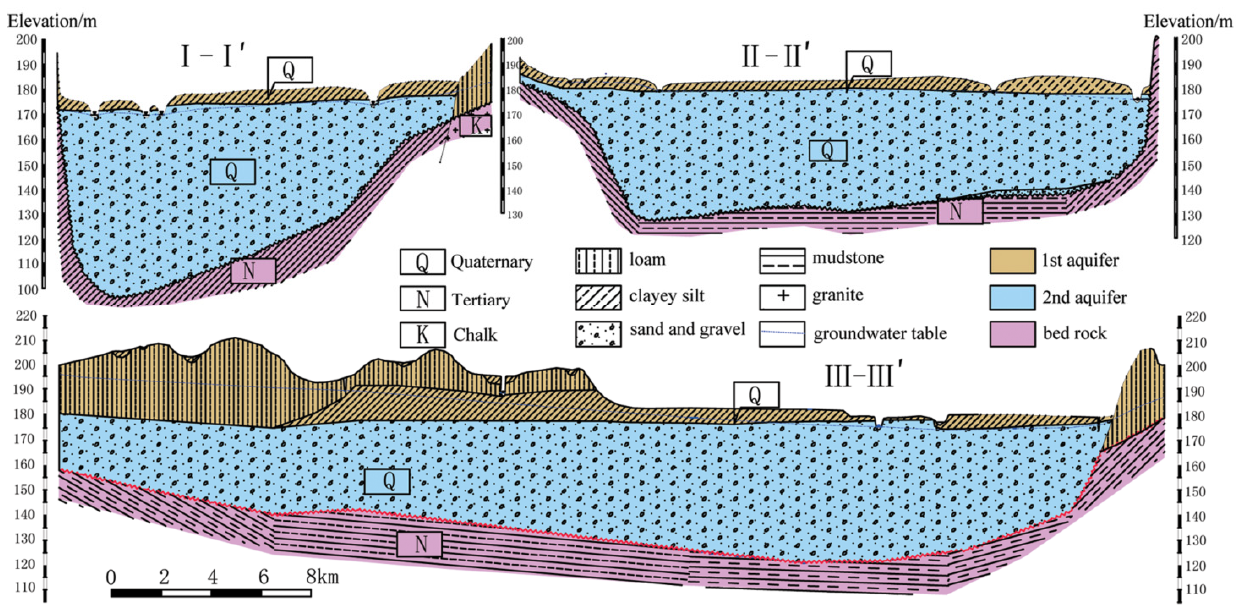
Figure 6. Hydrogeological cross-section of Jilin study area (location of the section lines